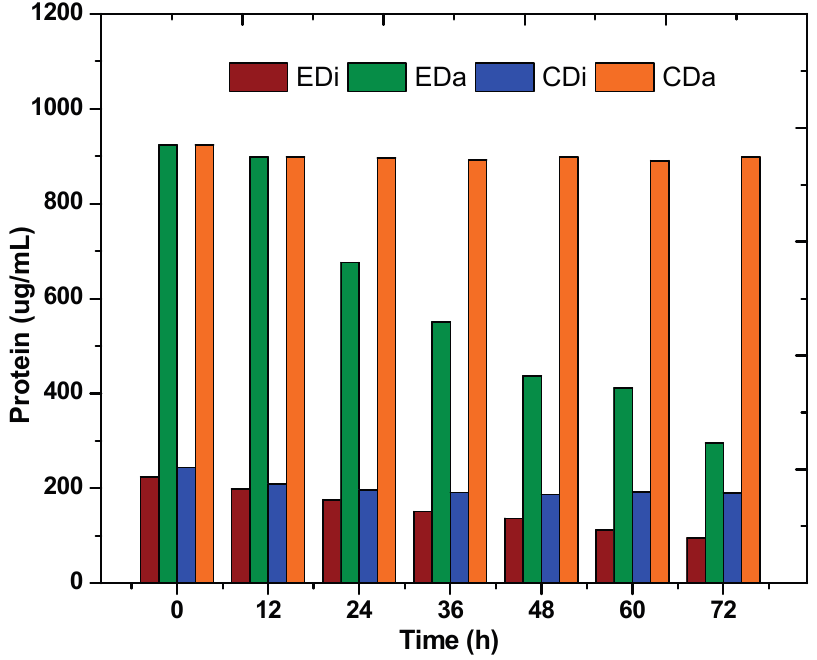
Figure 3. Variation in protein content in dark-fermentative system (DFS-CDi, CDa) and augmented dark-photo fermentative system (ADPFS-EDi, EDa) as a function of time with distillery and dairy